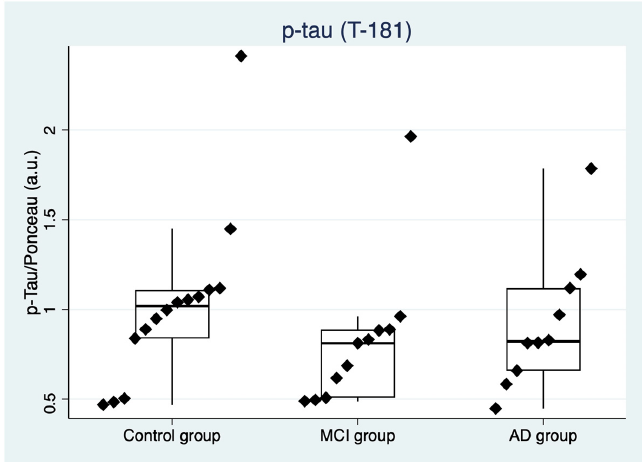
Figure 3. Strip plot showing the concentration of p-tau in the control group, in prodromal AD (MCI), and in mild-to-moderate AD. Boxes specify medians and quartiles, vertical spikes represent the largest or smallest value within the IQR of the upper or lower quartile. MCI: mild cognitive impairment due to Alzheimer’s disease, AD: Alzheimer’s disease.